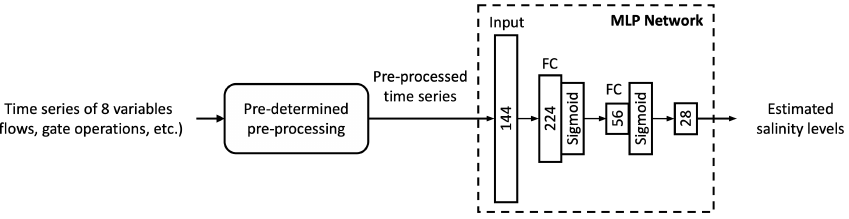
Figure 2. Architecture of the proposed MTL MLP Network. Numbers in layer blocks represent the numbers of